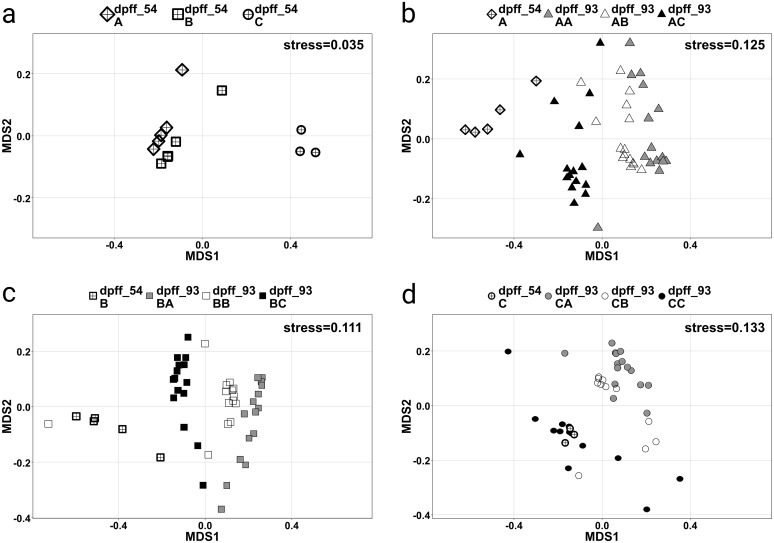
Nonmetric multidimensional scaling (NMDS) plots of the microbiomes of individual intestinal samples in relation to treatment and sampling day.MDS1 and MDS2 represent the two axes of the two-dimensional ordination space. Each point represents the microbiome of one individual fish. The stress-level shown in each plot indicates how well the individual distances between objects are represented (between 0 and 1; the closer to 0, the better are original data points represented in the ordination space). Plot (a) shows a comparison of samples by first feeding diet on day 54 pff. Plots (b), (c) and (d) compare the samples by second feeding diet on day 93 pff and continuously fed fish for both sampling days. The proximity between points represents the similarity of their microbiomes.